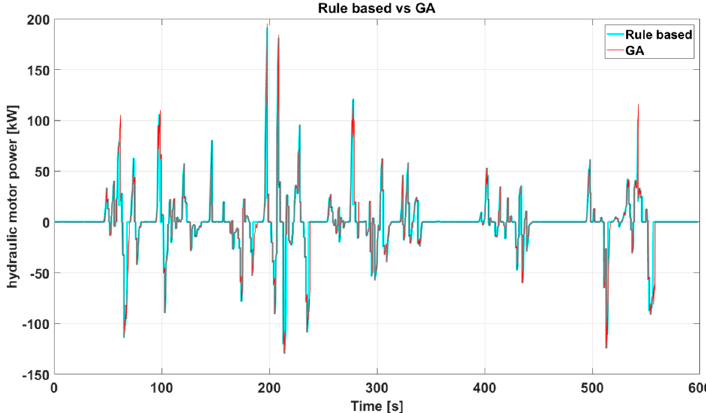
Figure 15. Comparison between HEHV (rule-based) and HEHV (GA) hydraulic motor power.